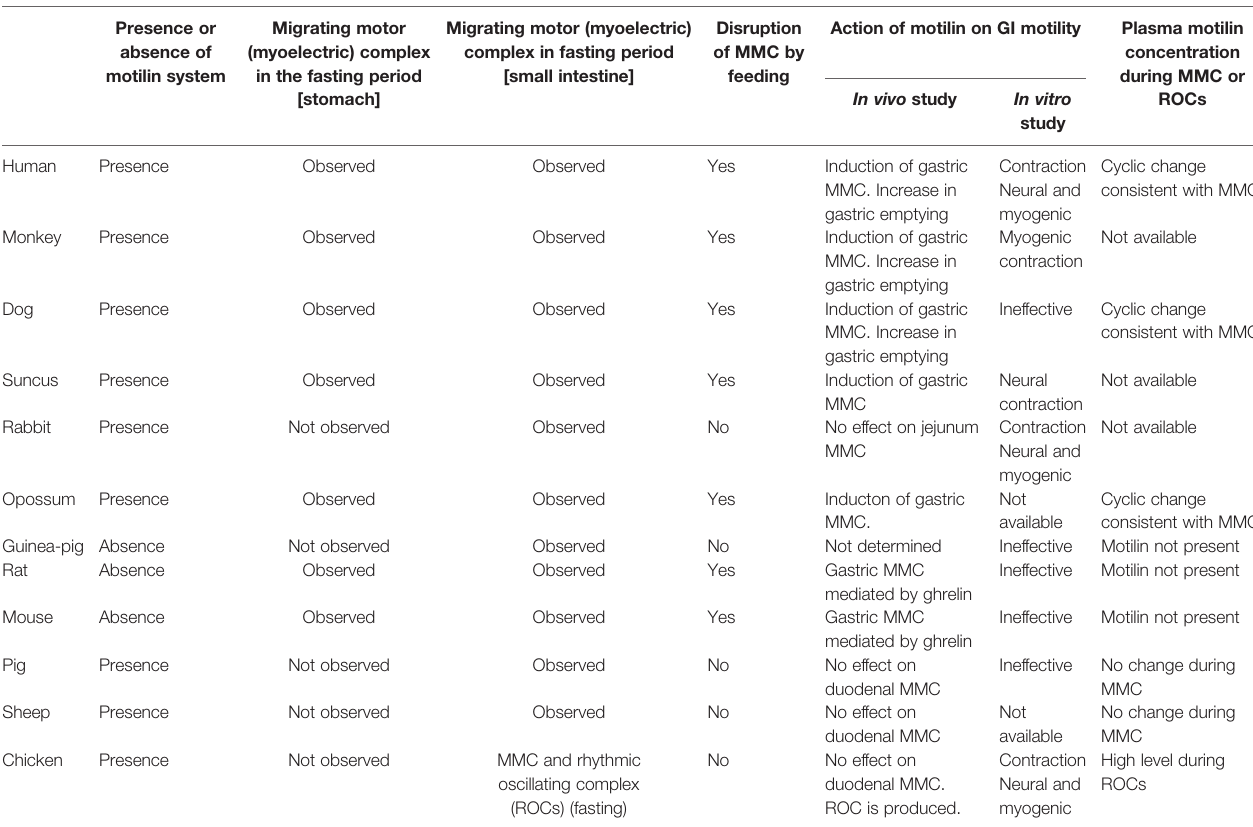
TABLE 3 | Summary of effects of motilin on gastrointestinal contraction in mammals and birds. Presence or absence